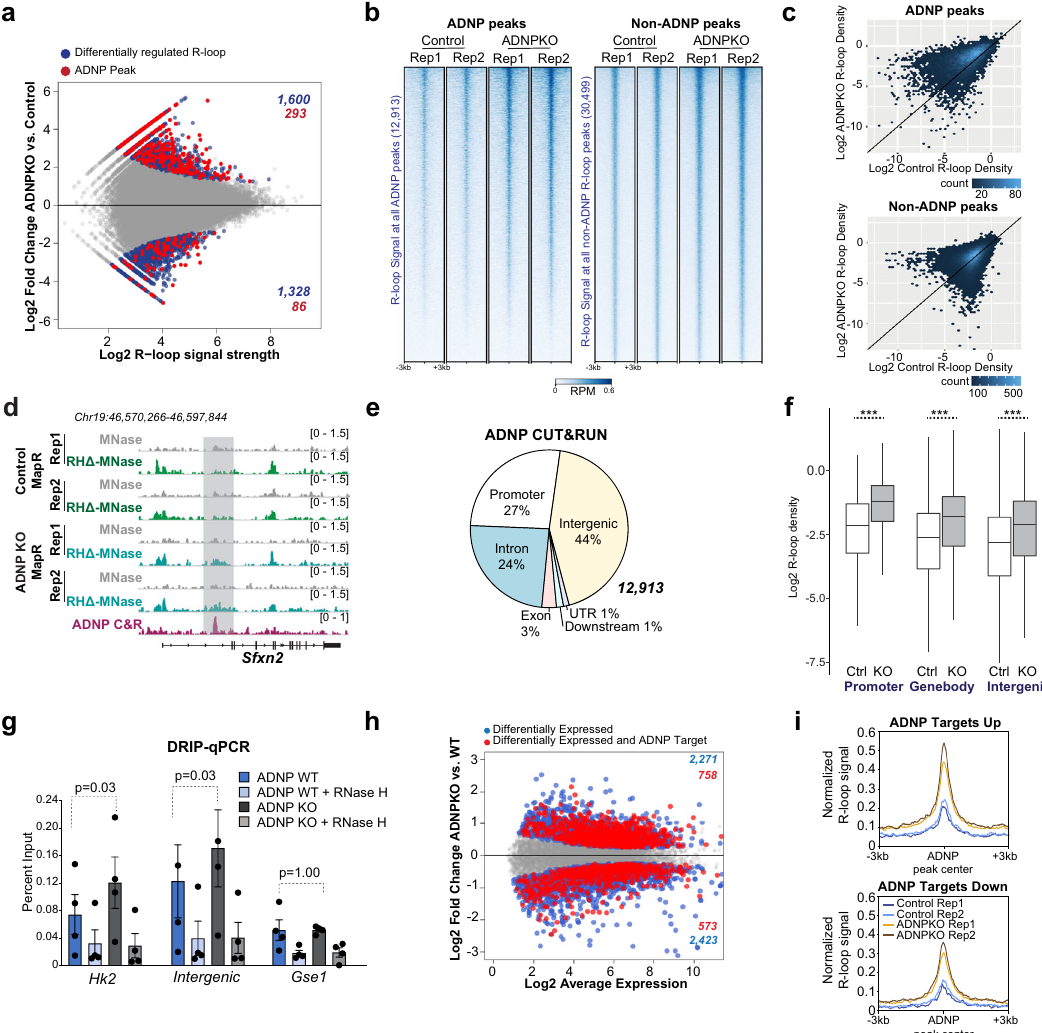
Fig. 5 ADNP suppresses R-loops at its binding sites in vivo. a MA plot of MapR signal in 61,652 R-loop peaks between Control (ADNP-KI) and ADNP KO mESCs. Blue dots indicate 2928 signi fi cant differential R-loop sites (FDR < = 0.05, DiffBind; 1600 up and 1328 down in KO). Signi fi cant differential R-loops that overlap an ADNP CUT&RUN peak (293 up, 86 down) are colored in red. b Heatmap of normalized MapR signal across 6-kb windows centered on ADNP peak locations (left) or control R-loop peaks that do not overlap ADNP peaks (right). Rows are sorted in decreasing order by mean signal across all samples. I Hexagonal-binned scatterplot of mean normalized MapR signal in control and ADNP KO mESCs across the regions shown in ( b ). d Genome browser view of the Sfxn2 gene showing MapR signal (RPM) in control and ADNP KO mESCs and ADNP CUT&RUN signal (RPM) in control mESCI. e Pie chart displaying distribution of 12,913 ADNP peaks across genomic features. f Boxplot displaying log2 normalized R-loop read densities in control and ADNP KO mESCs across ADNP peaks, grouped by genomic feature. *** p < 2.2 × 10 − 16 (Welch ’ s two-sided t -test; n = 3432 promoter peaks, 3653 gene body peaks, or 5828 intergenic peaks). Box, 25th percentile – median – 75th percentile. Whiskers extend to 1.5x interquartile range; outliers not displayed. g DRIP-qPCR results using the S9.6 antibody in WT and ADNP KO mESCs at an Hk2 gene region, an intergenic region, and a Gse1 gene control region. Bar chart, mean ± SEM; individual values shown as Dots. p , Welch ’ s two-sided t -test ( n = 4 biologically independent samples). h MA plot of RNA-Seq expression for 16,195 genes between WT and ADNP KO mESCs. Blue dots indicate differentially expressed genes (adjusted p -value < = 0.05; p -values computed by edgeR with Benjamini – Hochberg adjustment for multiple comparisons). Red dots indicate differentially expressed genes with an ADNP CUT&RUN peak within 3 kb of the gene body. i Signal plot of normalized control and ADNP KO MapR signal over ADNP peaks associated with ADNP target genes that are upregulated (1219 peaks) or downregulated (1040 peaks) in ADNP KO mESCs relative to WT. Source data underlying ( g ) are provided as a Source data fi Fig. 5k), consistent with ADNP ’ s role as a transcription repressor, transcriptional changes, but are instead a direct consequence of and a signi fi cant under-enrichment ( p = 2.7 × 10 − 5 , hypergeo- loss of ADNP binding. Thus, our data demonstrate an R-loop metric test) in downregulated genes (Supplementary Fig. 5k). We suppression function for ADNP at its own binding sites. then investigated R-loop signal at ADNP targets and found R-loop signal increased at ADNP binding sites associated with ADNP homeodomain deletion results in R-loop accumulation upregulated genes (Fig. 5i). Notably, R-loop signal also increased and compromises neuronal differentiation . Our data indicate at ADNP sites associated with downregulated genes (Fig. 5i), that deletion of the homeodomain signi fi cantly affects the R-loop suggesting these R-loop gains at ADNP sites are not coupled to resolution activity of ADNP (Fig. 4d) and that ADNP loss results